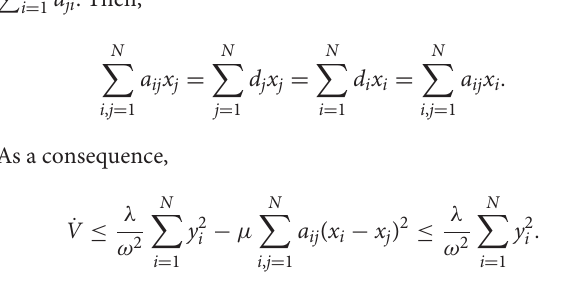
FIGURE 1 | Transition between global asymptotic stability and synchronous oscillation via Hopf bifurcation in system (1) for µ uniformly distributed in the interval [0.9,1.1] and varying λ . The interconnection topology is